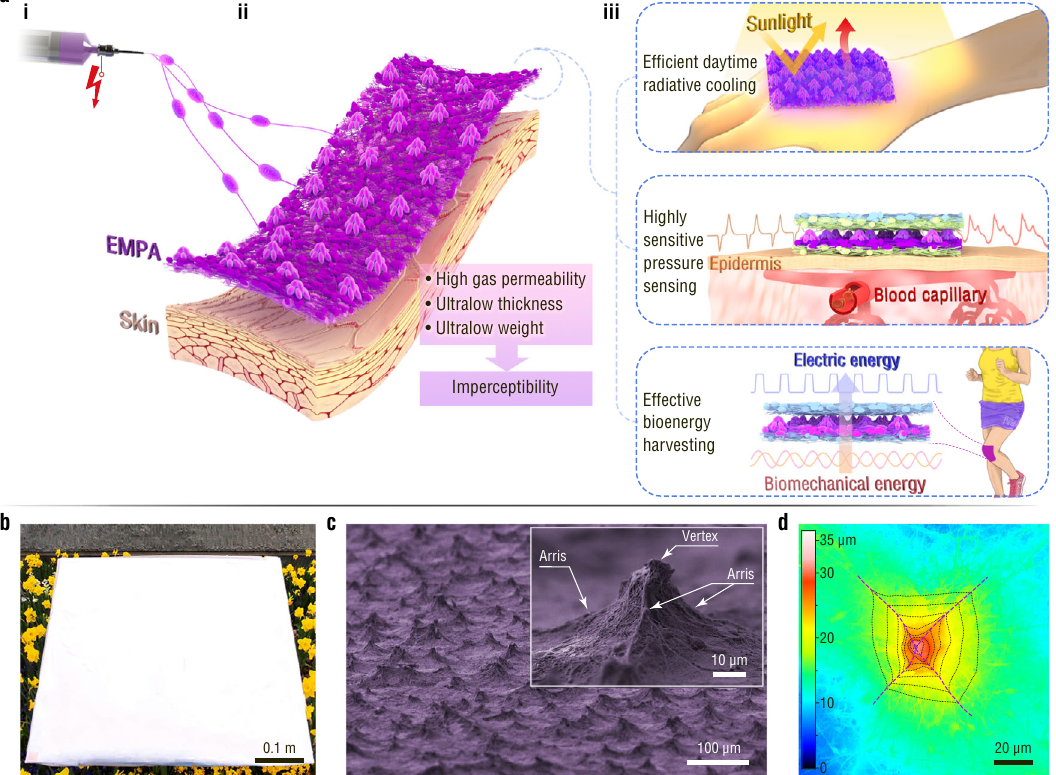
Fig.1|Materialstructuredesign.a Schematicillustrationofthe(i)fabrication,(ii) structure and (iii) application of EMPAs. b Photograph of a large-area EMPA-based fi lm. c SEM image of an EMPA. The inset shows a magni fi ed SEM image of an